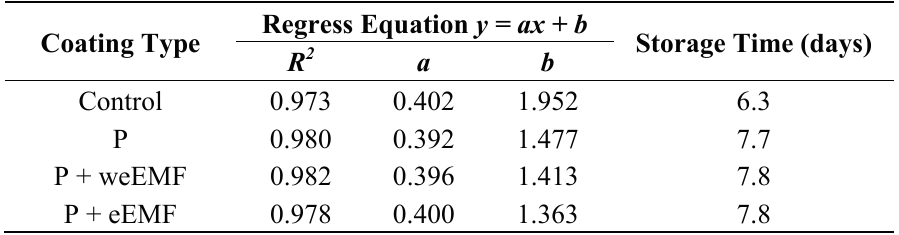
Table 3. The parameters of the regression equation describing the change of peppers weight loss during storage and the calculated storage time in which pepper achieve the maximum permissible weight losses of